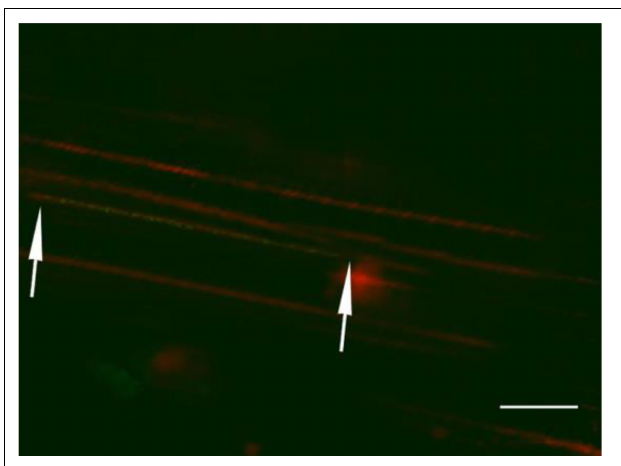
FIGURE 5 | Localization of 45S ribosomal DNA on extended DNA fiber of kiwifruit based on the fiber-fluorescence in situ hybridization protocol established and optimized in this study. The white scale bar represents 10 µ